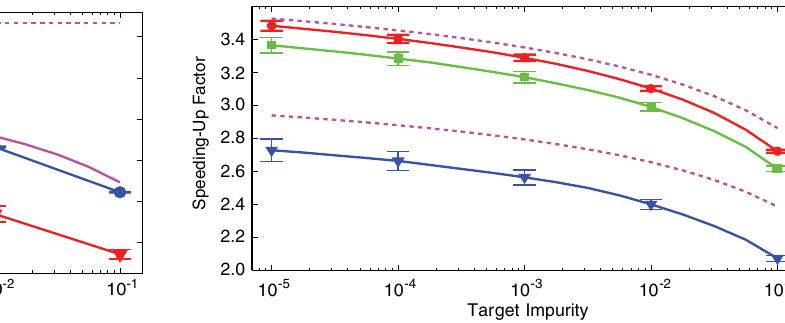
FIG. 4. Short-time numerically calculated speeding-up for D ¼ 3 . The dashed line is the analytically calculated asymptotic speeding-up S ¼ 8 = 3 ¼ 2 : _6 . The solid magenta line is the ideal speeding-up, calculated numerically from Eqs. (7) and (23). The circles and triangles are numerical calculations of the speeding- up with finite (cid:7)t ¼ 10 (cid:2) 3 (cid:2) (cid:2) 1 and 10 (cid:2) 2 (cid:2) (cid:2) 1 , respectively; the ensemble size is 100. As (cid:7)t ! 0 , the numerically calculated speeding-up approaches the solid line and the error bars vanish.